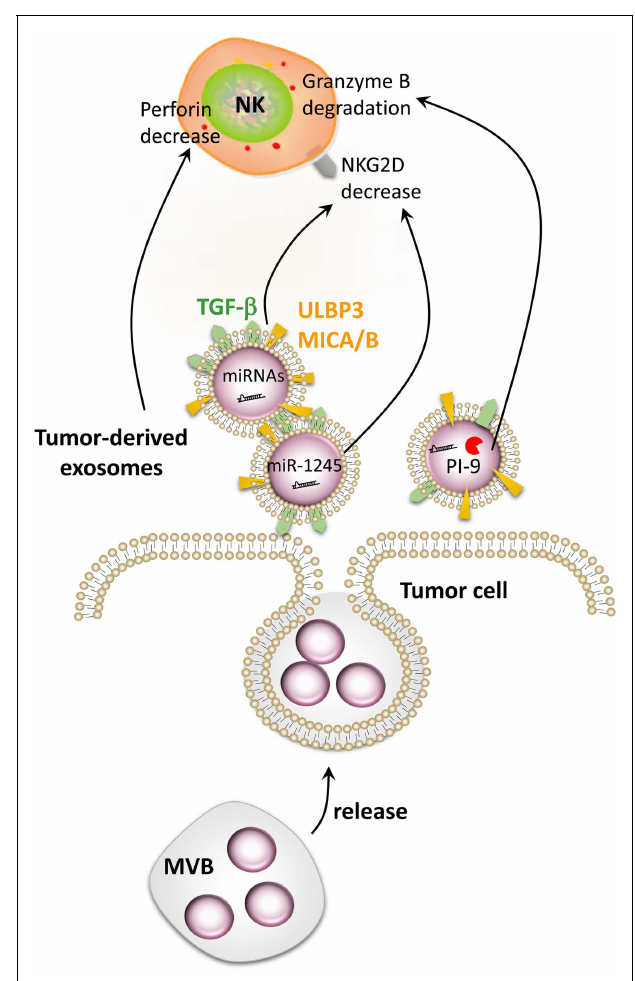
FIGURE 5 | Impairment of NK cell function by tumor-derived exosomes .Tumor cells secrete extracellular vesicles called exosomes. Tumor-derived exosomes contain numerous factors able to modulate the function of NK cells such as MICA/B, ULBP3,TGF- β , PI-9, and different microRNAs. Exosome-derived MICA/B, ULBP3,TGF- β , and miR-1245 can decrease NKG2D on the surface of NK cells, while PI-9 degrades granzyme B.Tumor-derived exosomes can also decrease the level of perforin in NK cells by a still-unknown